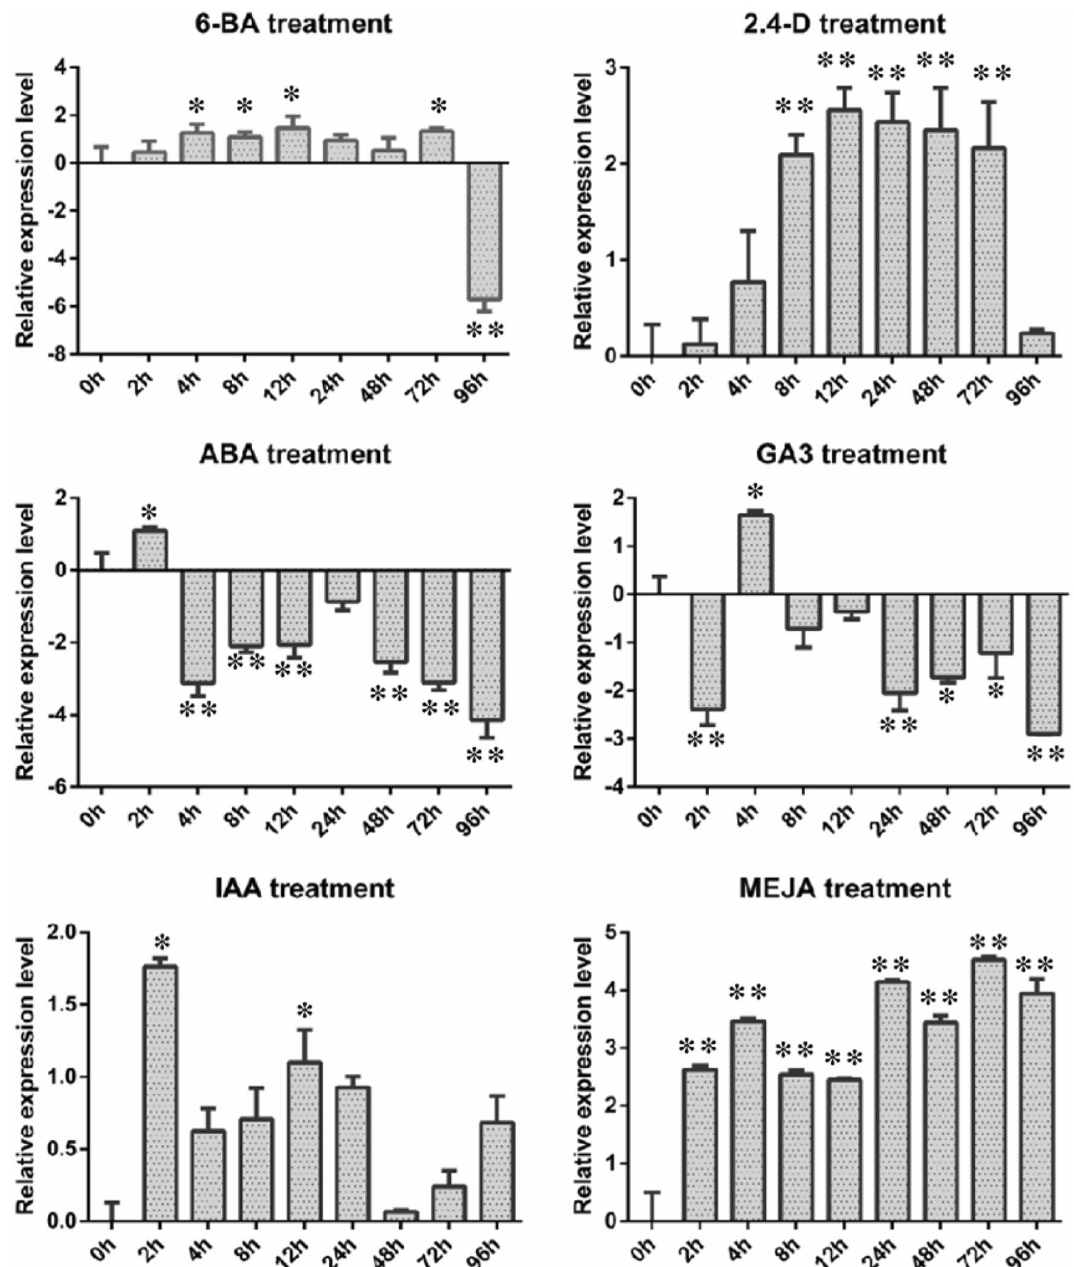
Figure 2. LoHDZ2 expression levels under different hormone treatments. *Compared with 0 h treatment, the difference was significant; **Compared with 0 h treatment, the difference was extremely significant.